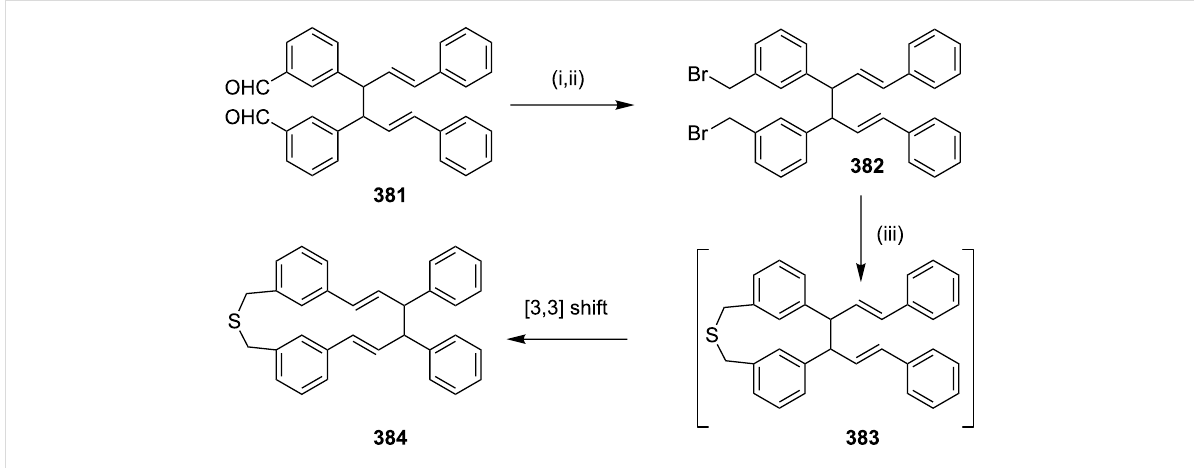
Scheme 69: Synthesis of metacyclophane via Cope rearrangement. Reagents and conditions: (i) MeOH, NaBH 4 , rt, 1 h, 95%; (ii) PBr 3 , C 6 H 5 CH 3 , Et